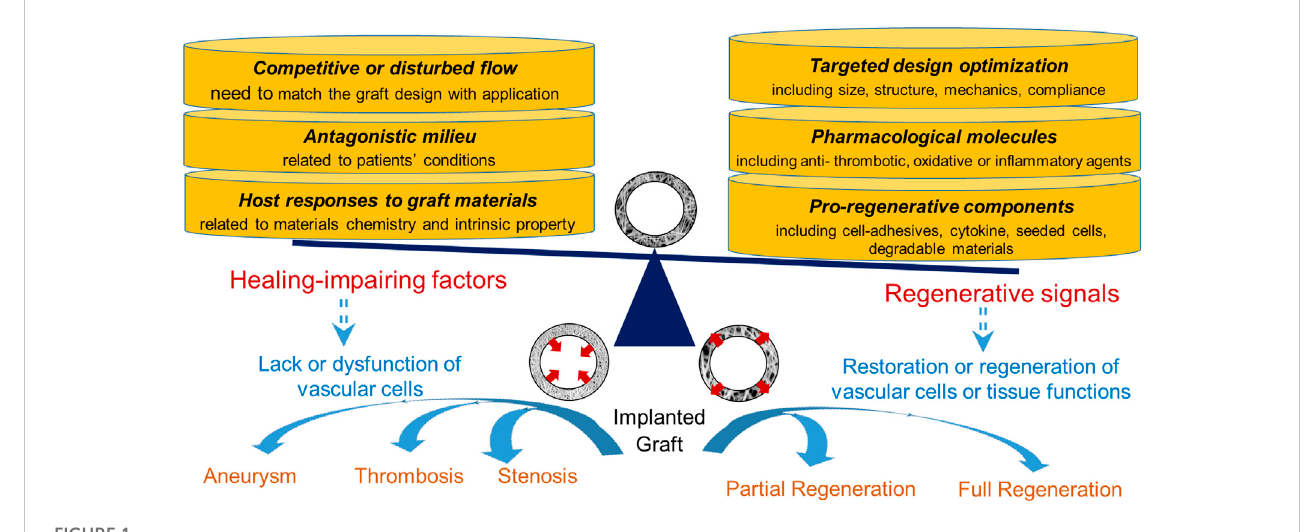
FIGURE 1 Illusration of impairment factors vs. regenerative signals for vascular